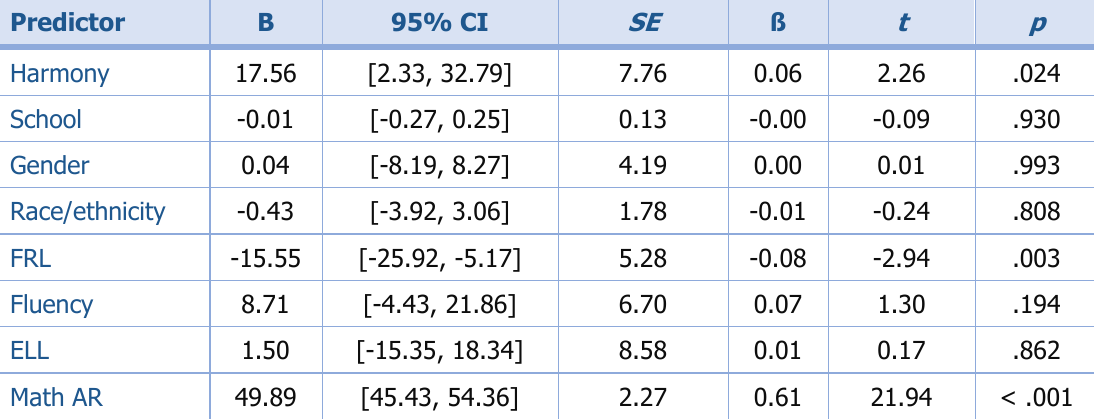
Table 5. Regression Coefficients of Model Predicting Math SBAC Scores 2 Years After Harmony Enrollment Period